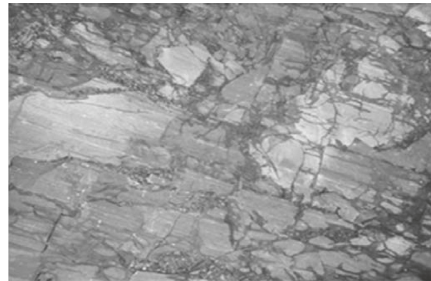
Figure 1: Schematic view of pre-existing defects in the natural rock mass.